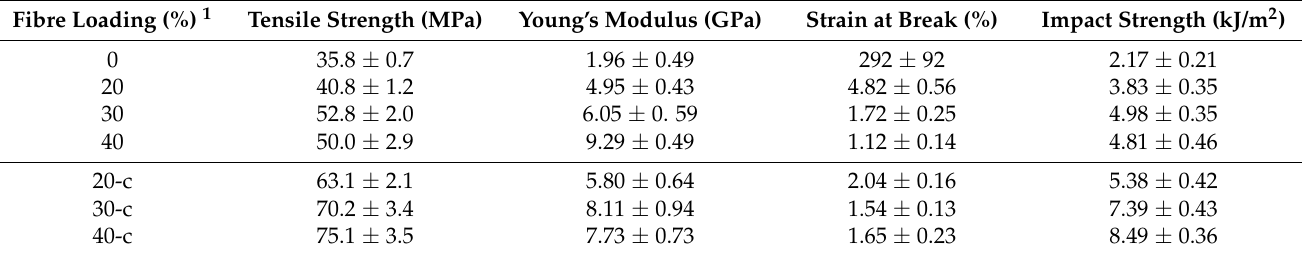
Figure 8. ( a ) Tensile strength and ( b ) impact strength of short BF-PP composites with and without the use of MAPP as compatibiliser. Table 6. Tensile and impact properties of the short BF- PP composites.